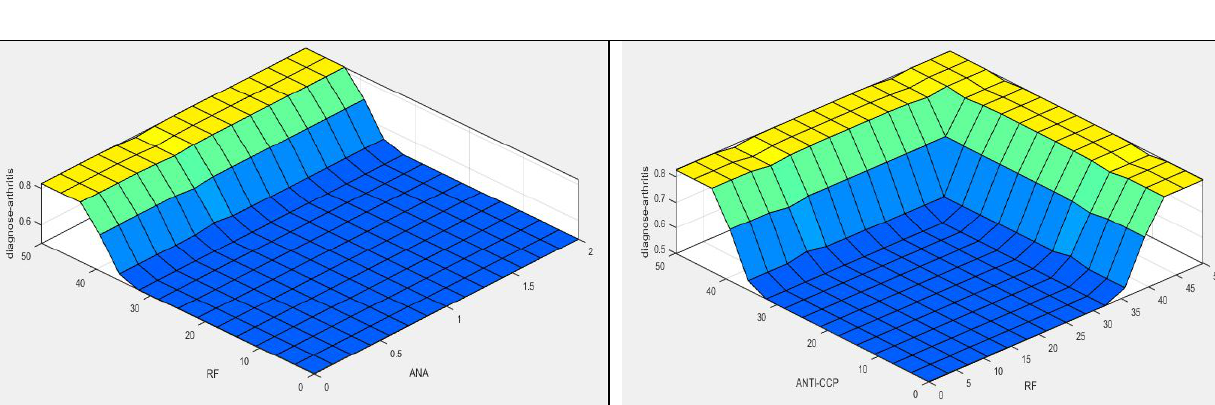
Figure 6. De-Fuzzifier graphical illustrations of Proposed DA-AH-MFES Expert System In Figure.6a blue color reperent the no arthritis , green color represent the acute arthritis and yellow color represent the chronic arthritis. The Arthritis (regarding Probability) based on Rheumatoid Factor and HLA-B27.